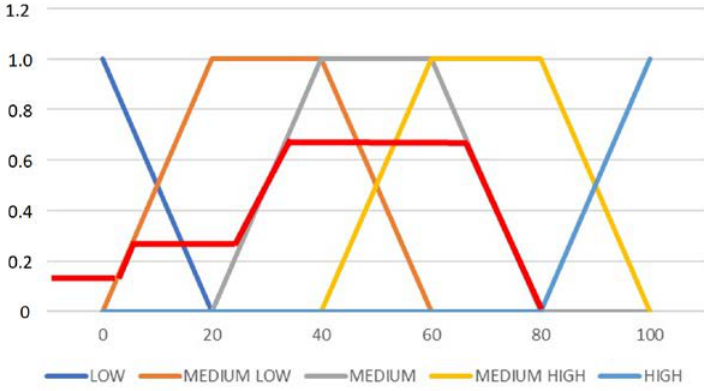
Figure 8. Aggregation of rules for assembly technology Substep 1.